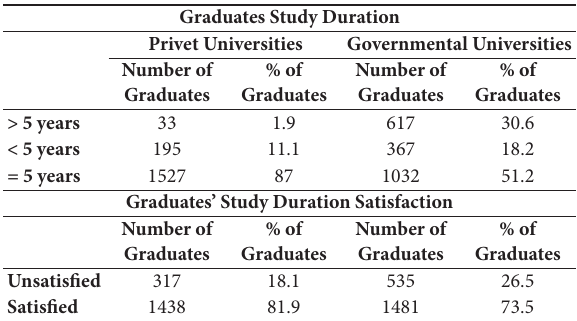
Table 2. Pharmacist duration of study and satisfaction between private and governmental universities in